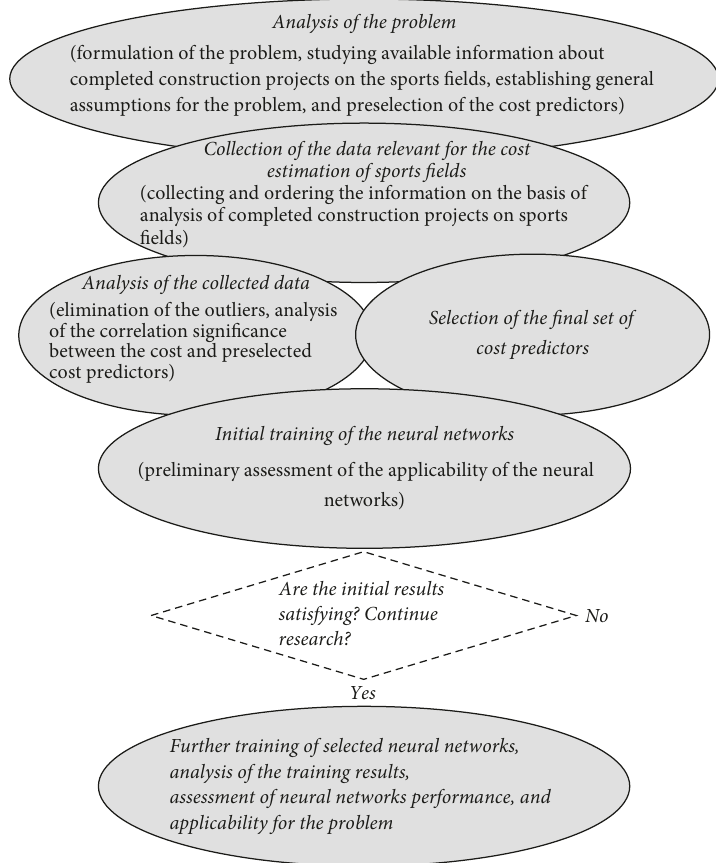
Figure 1: Scheme of the research framework (source: own